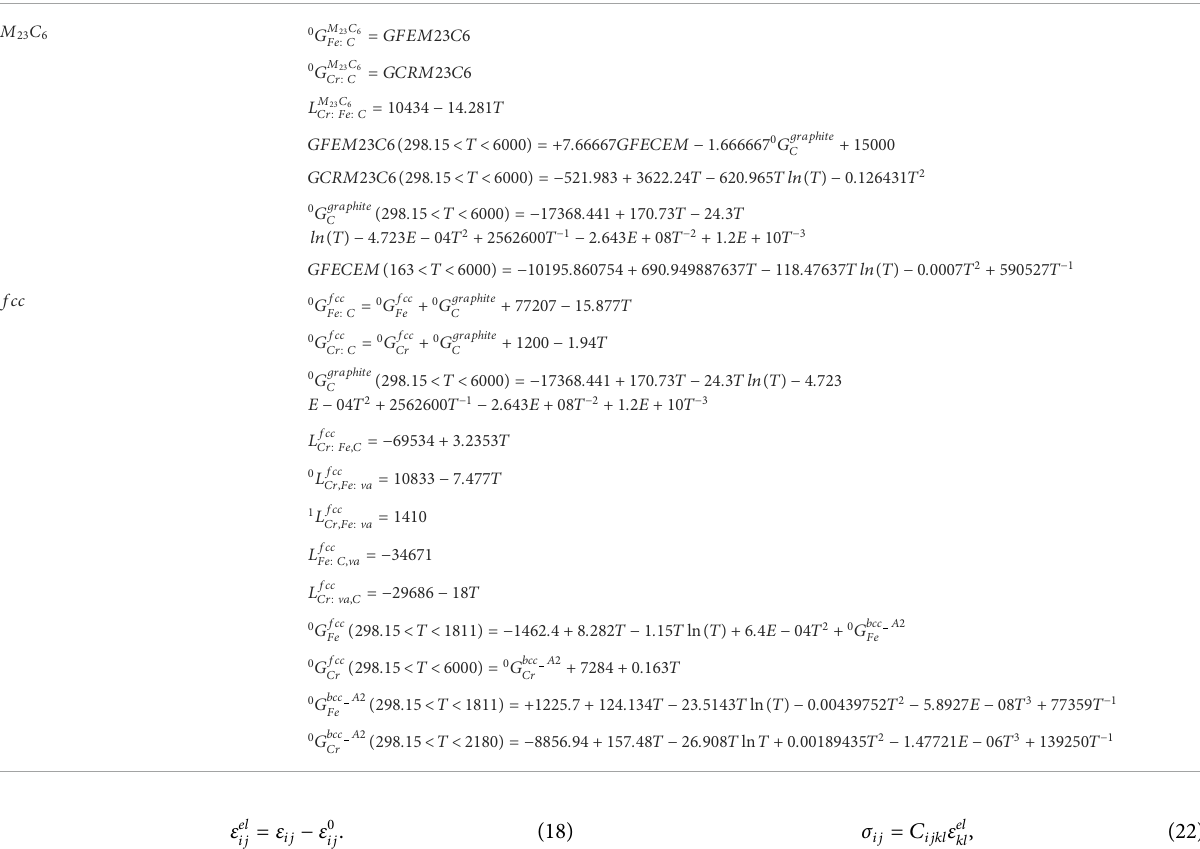
TABLE 3 Calculation parameters of thermodynamic parameters with the FCC and M 23 C 6 phases (Andersson, 1987; Andersson, 1988; Khvan et al., 2014). Phase Thermodynamic parameter ( J / mol ) M 23 C